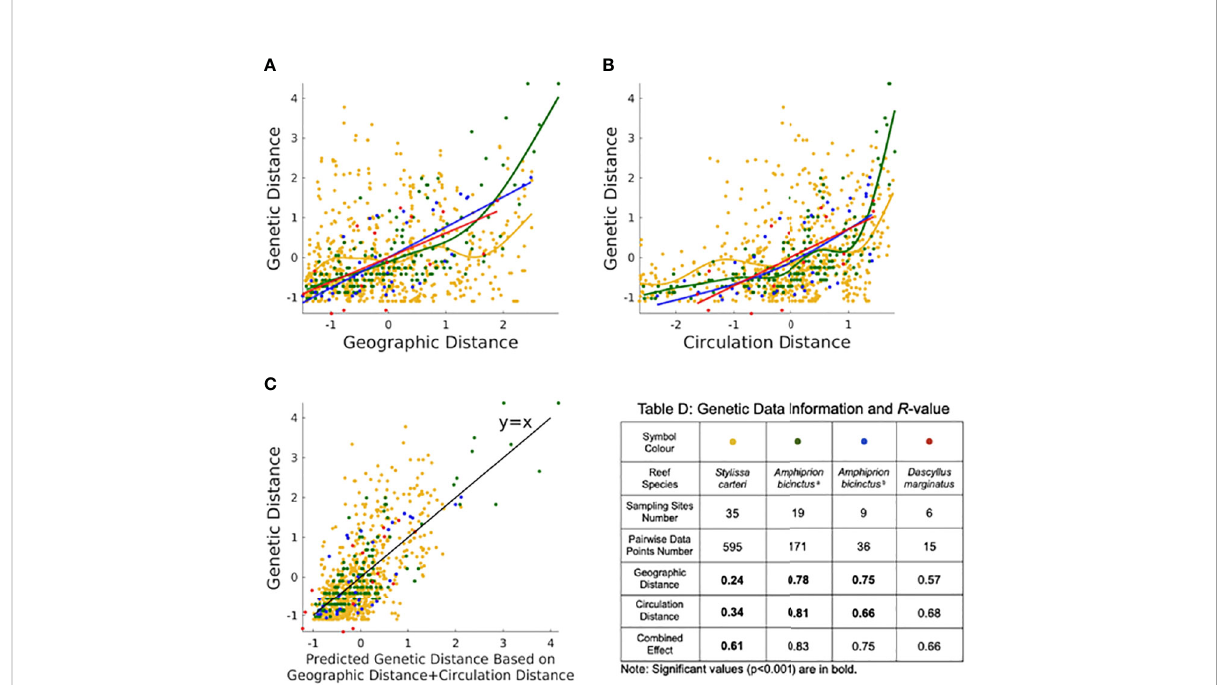
FIGURE 2 Statistical analysis using the Generalized Additive Model (GAM) for the (A) IBD theory, (B) IBC theory and (C) combined IBD with IBC. Legends for (A – C) are listed in Table (D) Genetic Data Information and R-value. The table provides information on the R values (R^2 is the coef fi cient of determination) for the four datasets of the reef sponge S. carteri and the reef fi sh A. bicinctusa, A. bicinctusb and D. marginatus. Data were standardized to a mean of zero and a standard deviation of one. Note that the black line in (C) is y = x